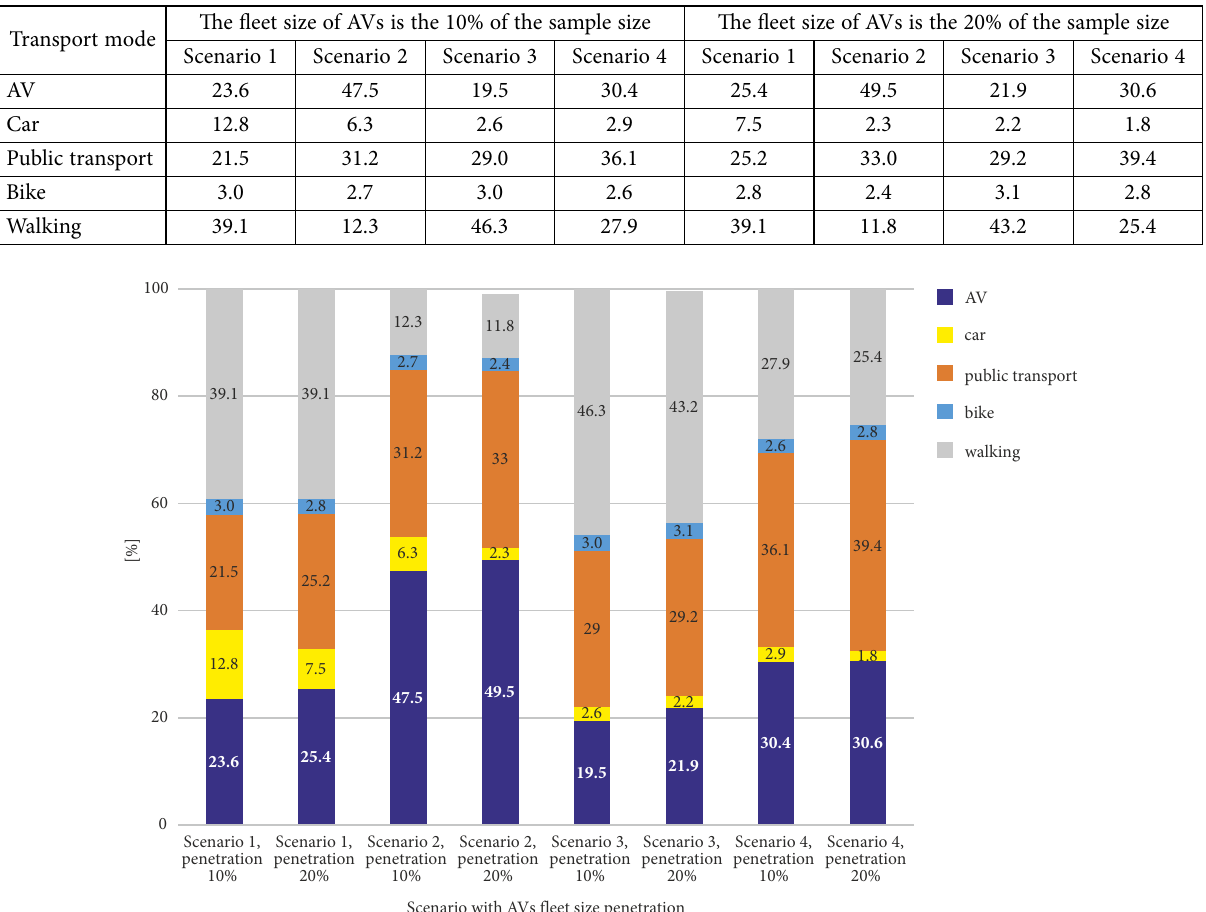
Figure 8. The mode-share shift results when the AVs penetration increases from 10 to